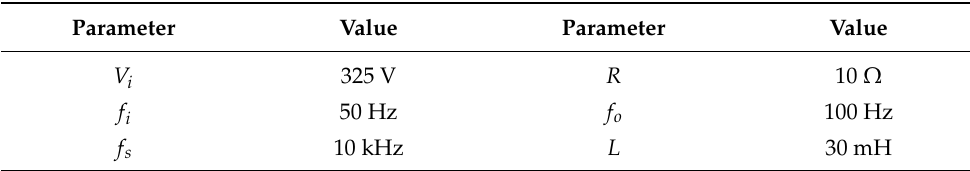
Table 8. Parameters used in the simulation.